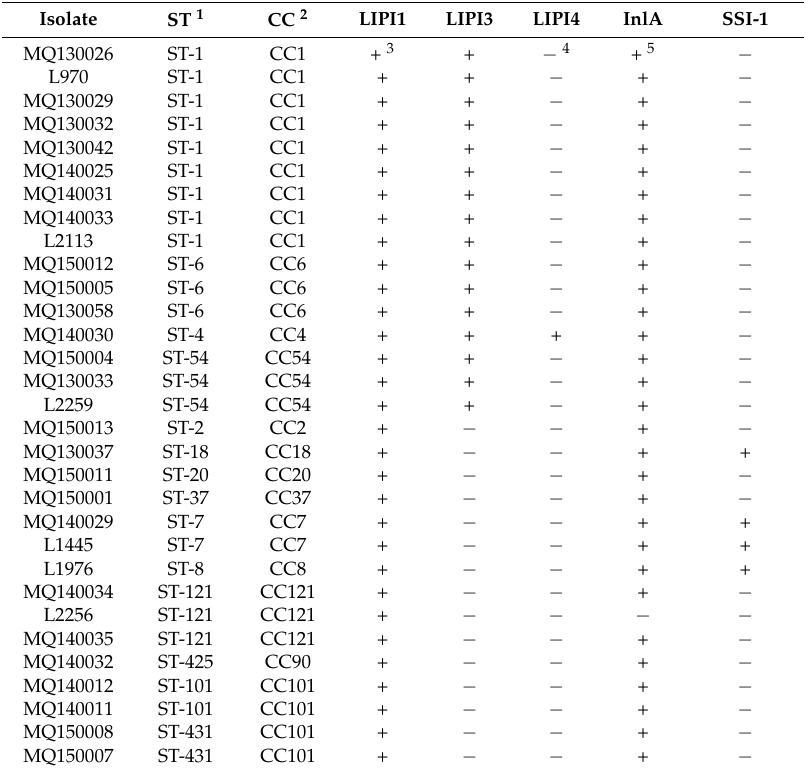
Table 3. Presence or absence of key loci encoding L. monocytogenes virulence-associated elements or loci putatively involved in environmental